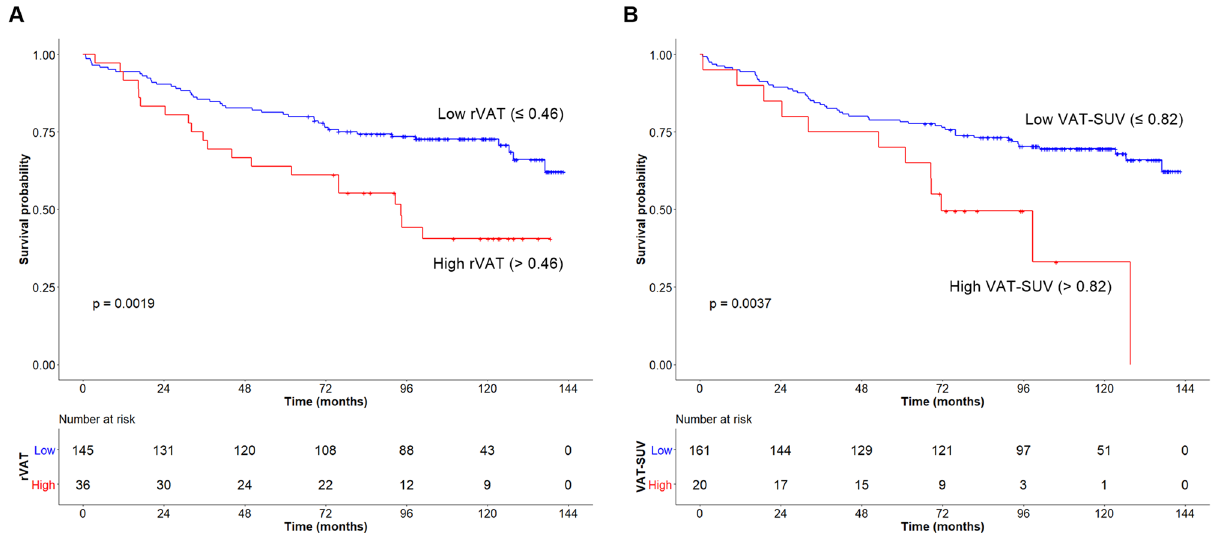
Figure 2. Kaplan–Meier curves of overall survival stratified according to rVAT ( A ) and VAT-SUV ( B ) in males (n =